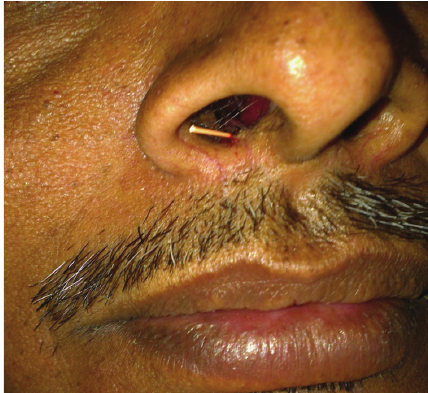
Figure 1: Extraoral view showing sinus tract opening at the base of the right nostril.